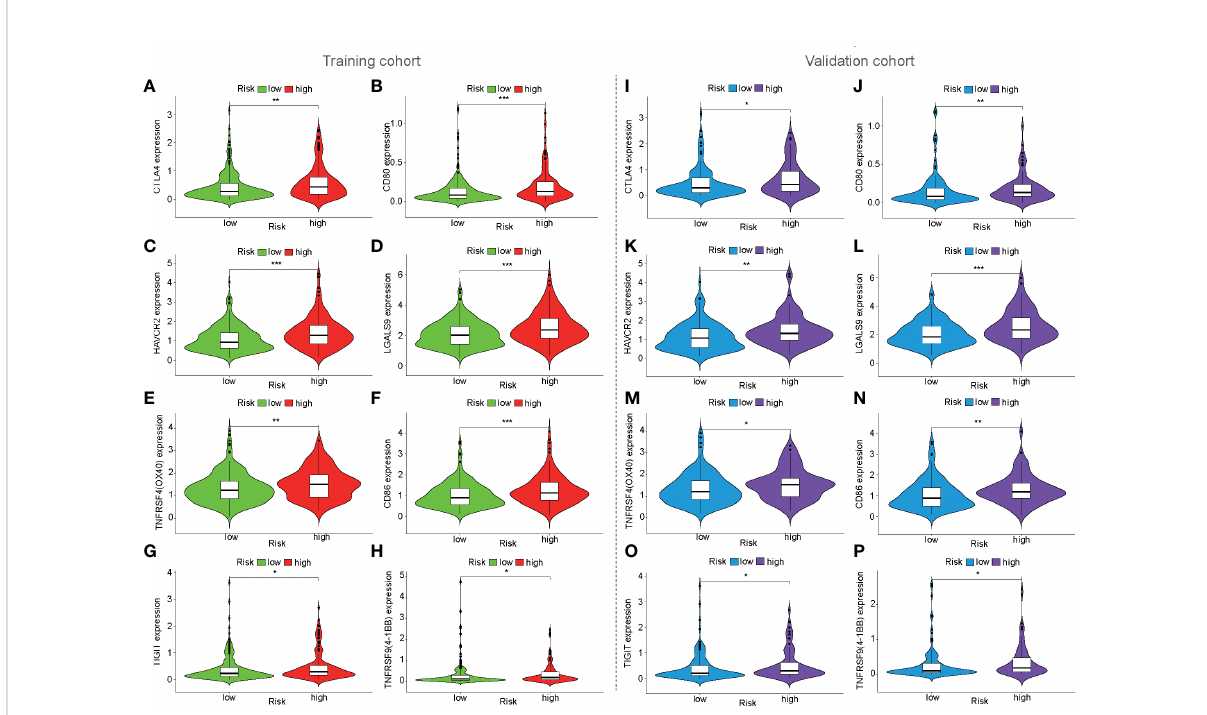
FIGURE 7 Expressionof immune checkpoints based onmfrlncRNA signature. (A – H) The expressionof immune checkpoints between high- and low-risk populations in the training cohort. (I – P) Expression ofimmune checkpoints in the validationcohort. ( p > 0.05; * p < 0.05; ** p < 0.01; *** p <